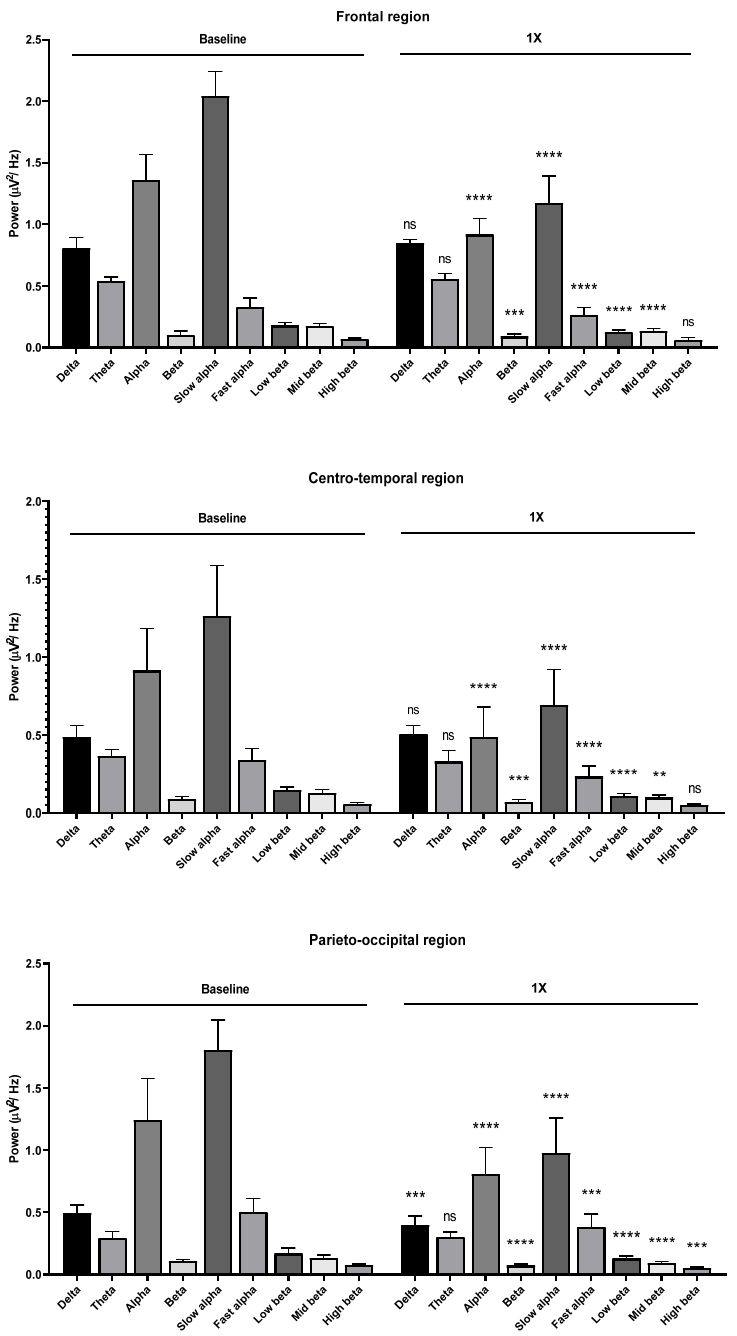
Figure 5. Effects of Litsea cubeba oil inhalation of an undiluted dilution (1X) on the delta, theta, alpha, beta, slow alpha, fast alpha, low beta, mid beta, and high beta wave powers: ( upper ) frontal region; ( middle ) centro-temporal region; ( lower ) parieto-occipital region. p value: not significant (ns) ≥ 0.05, ** < 0.01, *** < 0.001, and **** < 0.0001.